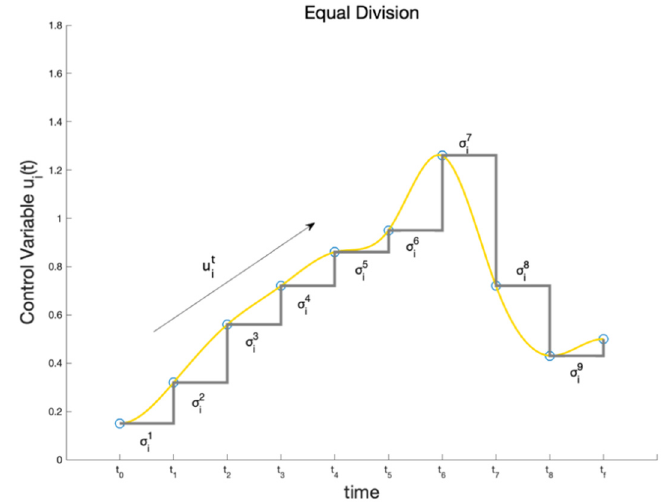
Figure 2. Equal division model.